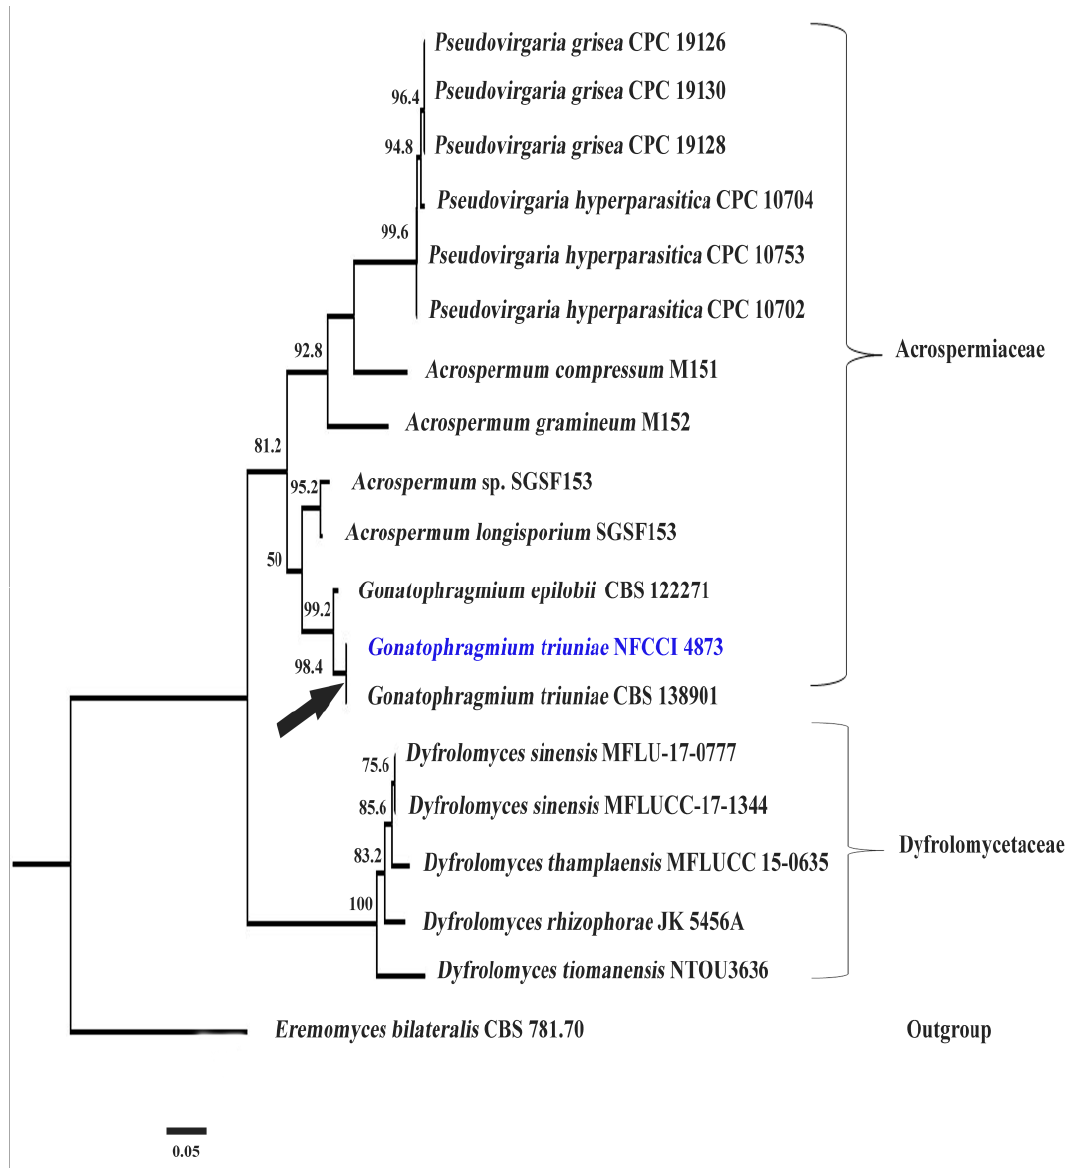
Figure 2. Phylogenetic tree of G. triuniae NFCCI 4873 based on the combined ITS & LSU rDNA sequence data. Digits on the nodes represent the likelihood bootstrap values.